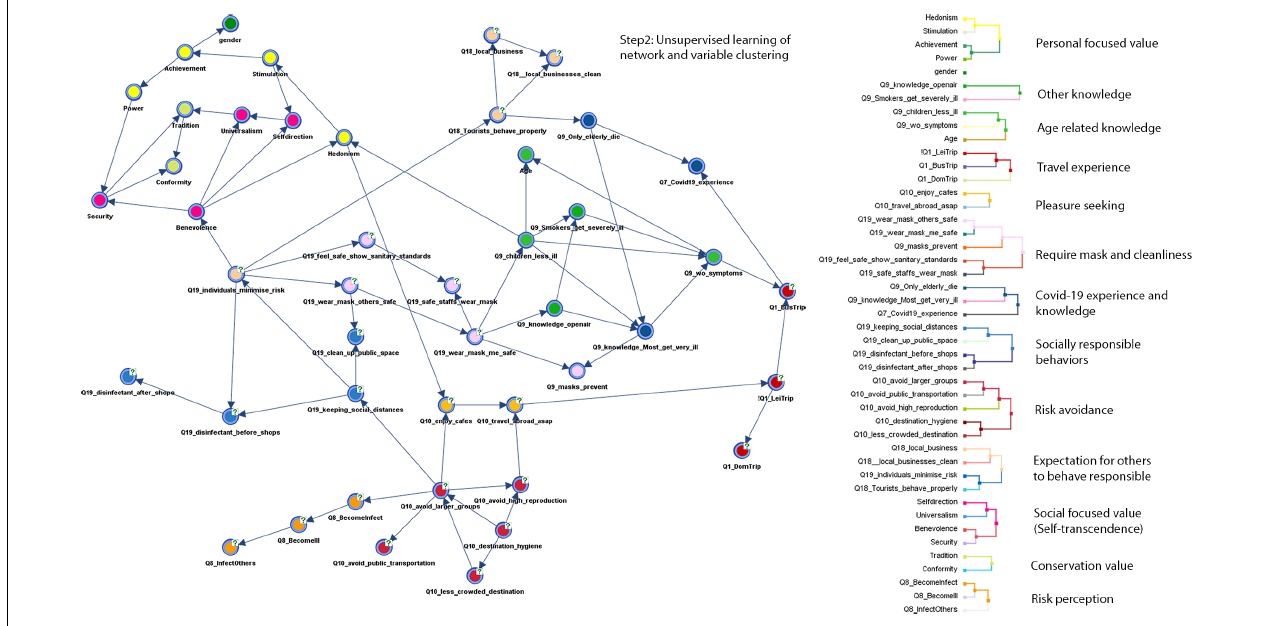
FIGURE 4 | Step 2: An overview of networks (left) and variable clusters (right) acquired from the unsupervised learning.